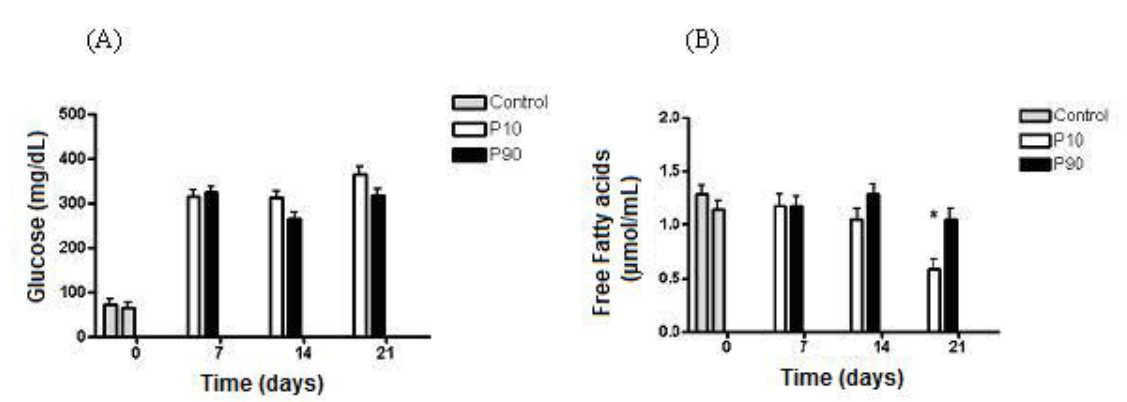
Figure 1. Glycemia ( A ) and free fatty acids ( B ) concentration of control group and propolis treated rats (P10 or P90) after 7, 14 and 21 days of streptozotocin administration. *Significantly different from day 0 (p < 0.05)